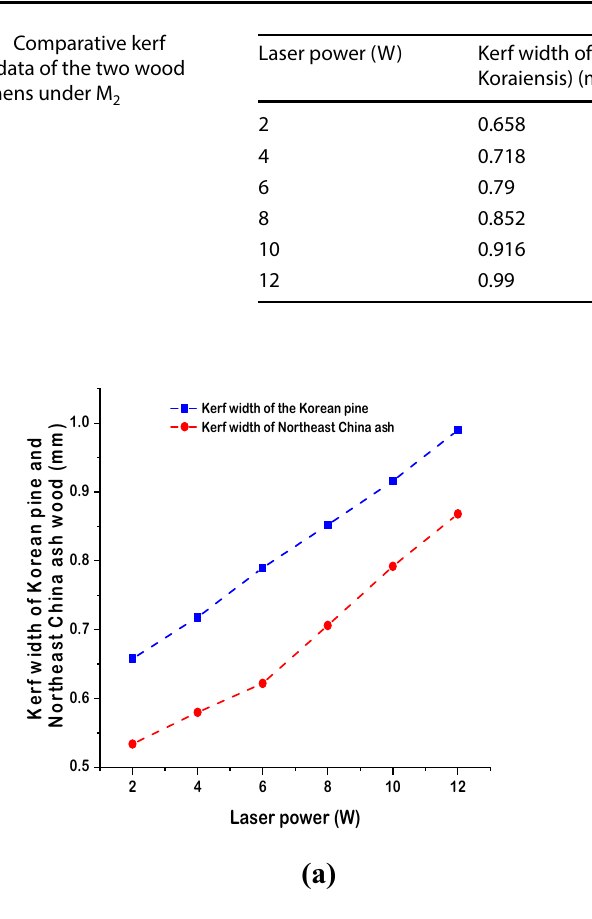
Fig. 12 Joint view of kerf width as a function of laser power of the two types of wood a Kerf width, b Histogram